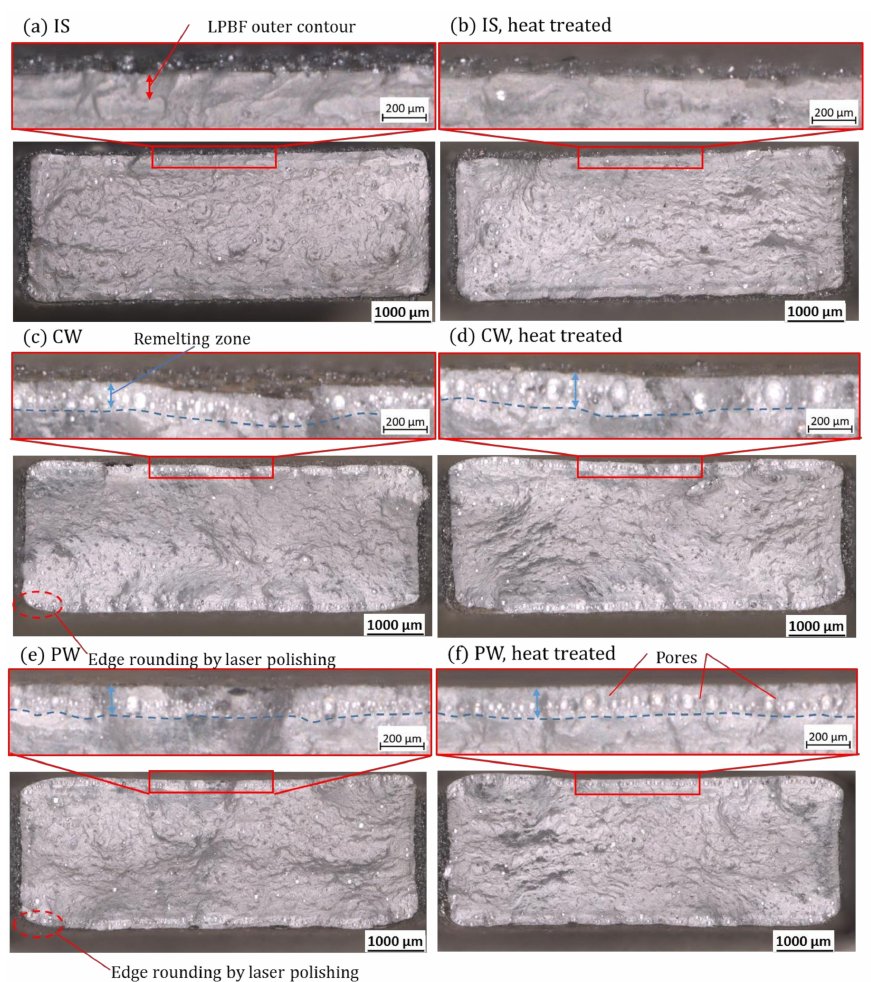
Figure 26. Fracture plain of the tensile specimens at the L-PBF state ( a ), with heat treatment ( b ) laser polished ( c , d ) and polished after heat treatment ( e , f